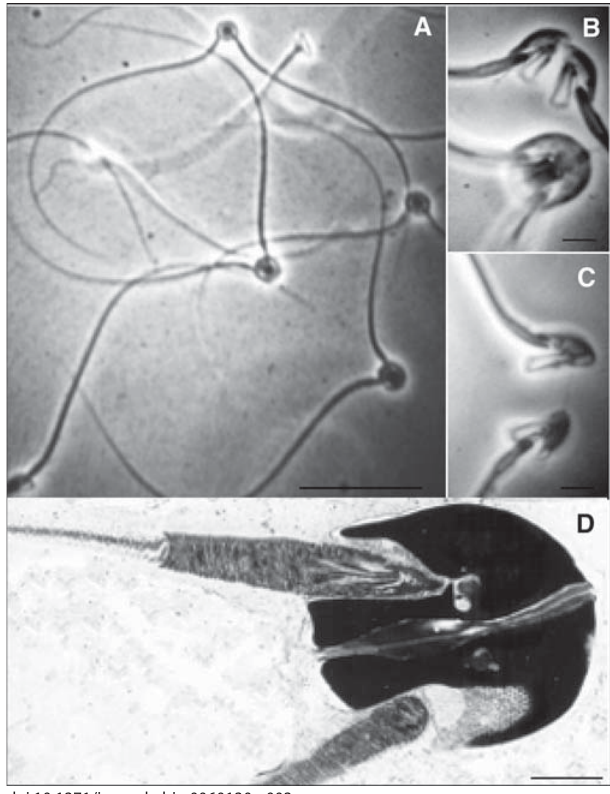
Figure 3. Conjugate Sperm Pairs in American Opossums (A) Paired and single sperm of the short-tailed opossum Monodelphis domestica . (B) Pairs of conjugate sperm attached by the heads, the top pair starting to separate after capacitation. (C) Pair of conjugate sperm separating. (D) Electron microscopy of exquisite sperm head alignment in conjugate sperm pair (credit: Harry